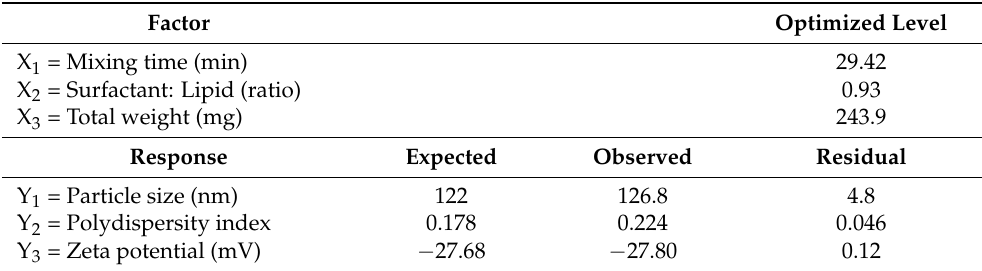
Table 5. Predicted and observed values of the physicochemical characteristics of the optimized tadalafil-loaded